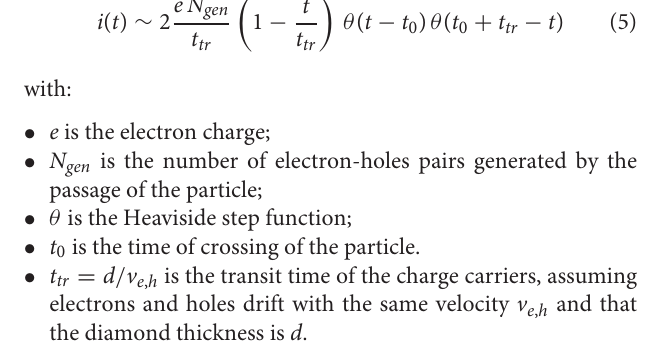
2V/ µ m). On the right the 1 /λ for each type of diamond − 2V/ µ m. Adapted from Bäni et al. [19] under the Creative ±